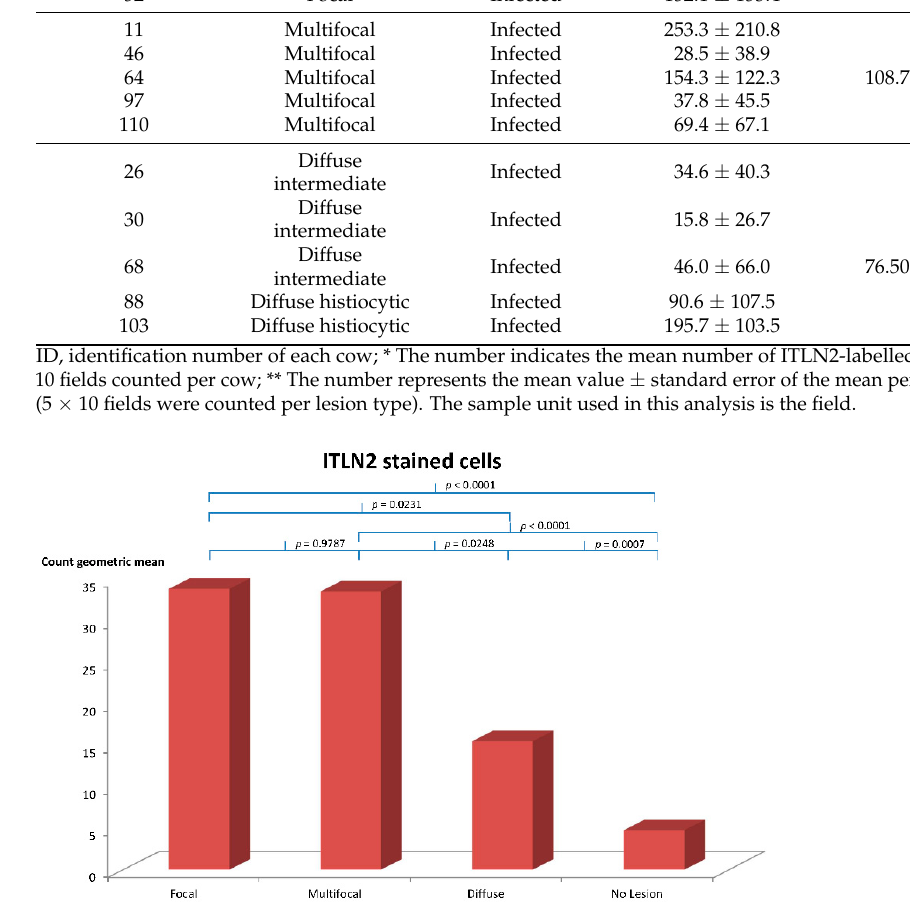
Figure 2. Quantification of positively immunolabelled Paneth and goblet cells in the ileocecal valve represented by the geometric mean of the number of ITLN2-stained cells per cow for each lesion type (focal, multifocal and diffuse) and the control with no lesions detected.